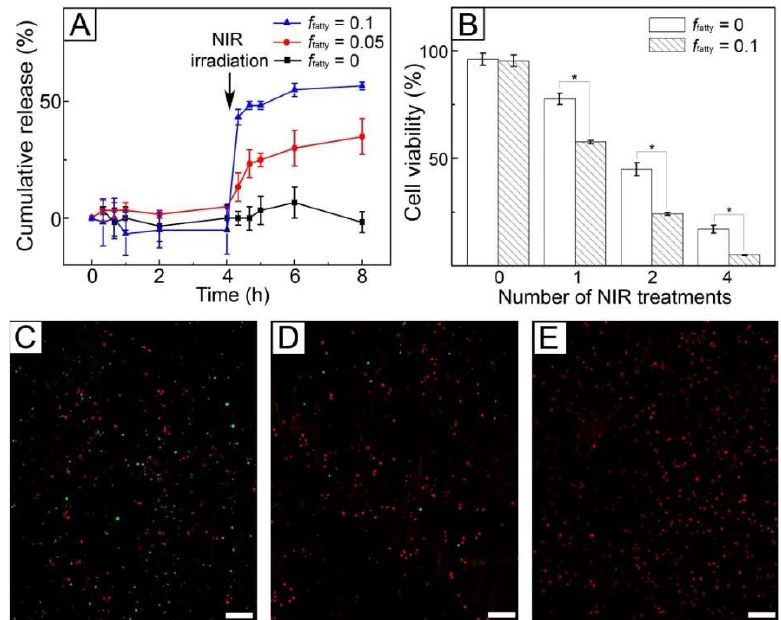
Figure 7. ( A ) Release profiles of DOX from AuNC-loaded fibers containing the fatty acid mixture and the drug. The cumulative release (%) percentage was defined as a ratio of the accumulated amount of released drug at a given time to the initial amount loaded. ( B ) Viability of SK-BR-3 cells treated with AuNC-loaded fibers containing the fatty acid mixture and DOX under different numbers of cycles of 1 W/cm 2 NIR light irradiation. The fibers were made using W/O emulsions of f fatty = 0 and 0.1. * indicates p < 0.01. ( C – E ) CLS micrographs showing live (green) and dead (red) SK-BR-3 cells treated with the fibers of f fatty = 0.1 under different numbers of cycles of 1 W/cm 2 NIR light irradiation: ( C ) one, ( D ) two, and ( E ) four cycles. The scale bars are 100 μm.